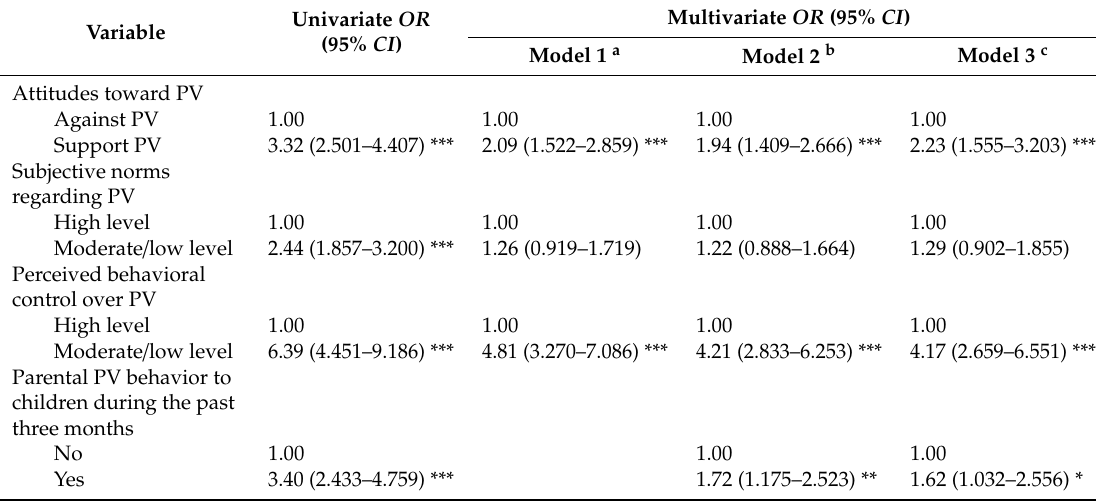
Table 3. Logistic regression models of factors that predict parents’ intentions to use PV toward their preschool children in the